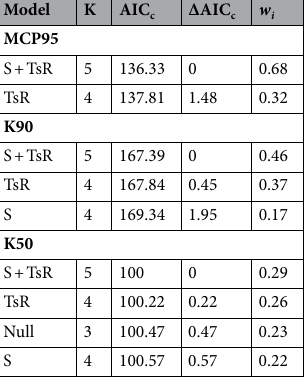
Table 3. Best ranked GLMM models relating territory size (MCP95 and K90) and core area (K50) with sex (S), time since release (TsR), rabbit abundance (RA), and lynx density (LD). Only models with ΔAIC c < 2 are shown.